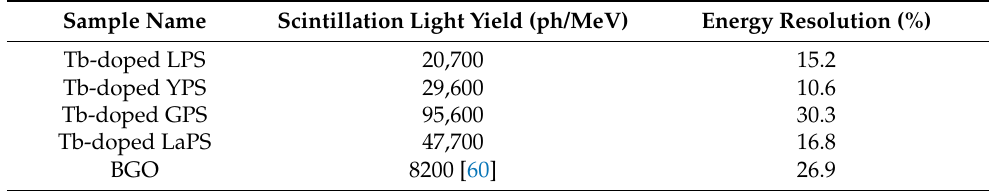
Figure 9. Pulse-height spectra of Tb-doped LPS, YPS, GPS, and LaPS samples, under the 137 Cs (662 keV) γ -ray. With the spectrum of the BGO reference sample. Table 1. Absolute scintillation light yields and energy resolution of the Tb-doped pyrosilicate samples under 662 keV γ -ray